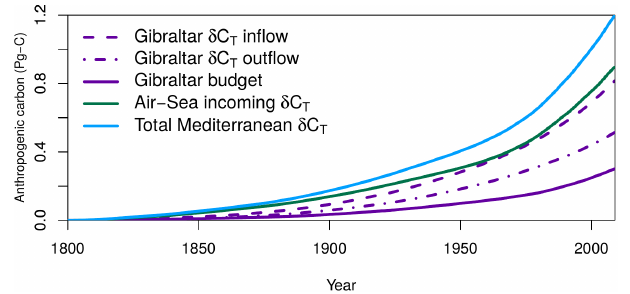
Figure 7. Cumulative increase in anthropogenic carbon (PgC) in the Mediterranean Sea from 1800 to 2008 due to the Gibraltar in- flow (dashed purple line) and outflow (dashed-dotted purple line), i.e., their difference (inflow – outflow, solid purple line) and the air– sea flux (solid green line). Also shown is the total buildup in storage (solid light-blue line). Gibraltar fluxes have been calculated from model monthly mean outputs by multiplying the anthropogenic car- bon concentration (gm − 3 ) of water in a section crossing the Strait of Gibraltar by water fluxes (m 3 month − 1 ) flowing across this sec- tion. The sign of the water flux indicates its direction, and hence provides an inflow or an outflow of anthropogenic carbon. The total storage is the sum of the net δC T flux at the Strait of Gibraltar and of the δC T air–sea flux, and is consistent with the sum of all the δC T store in the Mediterranean Sea.